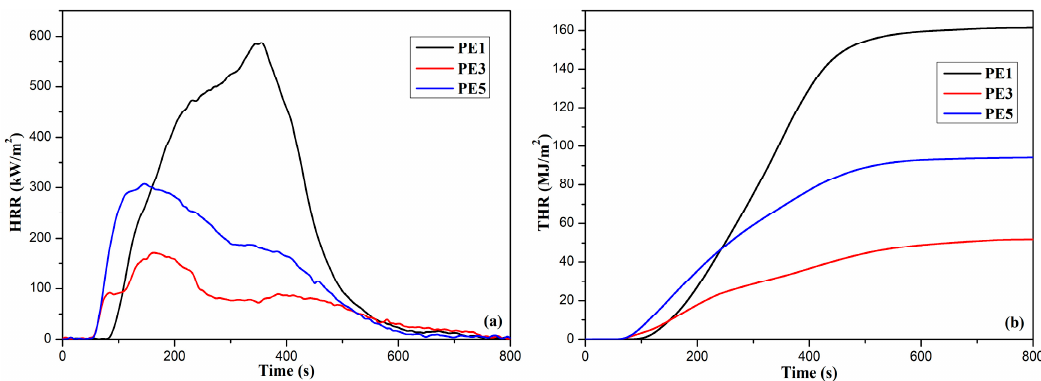
Figure 5. Heat release rate ( a ) and total heat release ( b ) curves of HDPE and HDPE / IFR composites. Table 3. Characteristic parameters of the cone calorimetric test (CCT) for HDPE and HDPE/IFR composites.